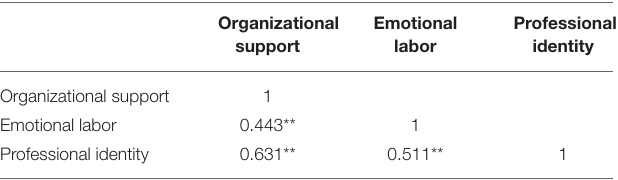
TABLE 6 | Pearson’s correlation analysis of variables ( N = 170). FIGURE 2 | Mediating effect model of professional identity on the relationship between perceived organizational support and emotional labor.